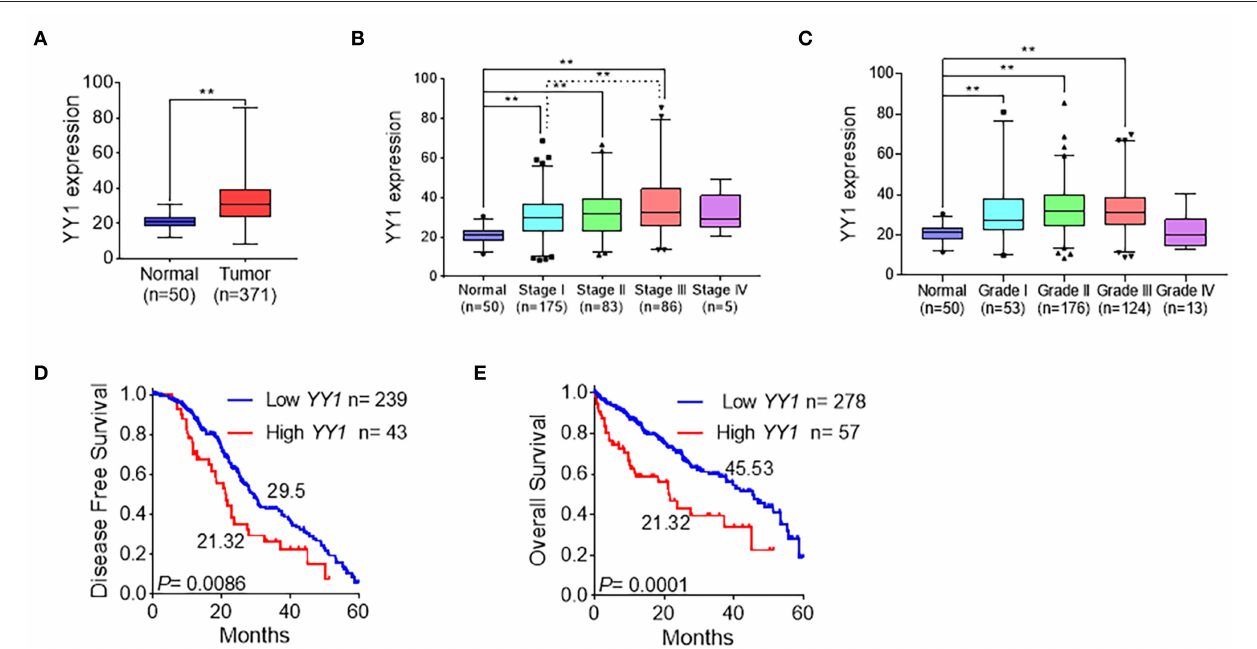
FIGURE 2 | YY1 indicated tumor malignancy in HCC. (A) Expression level of YY1 in primary tumors ( n = 371) and normal liver tissues ( n = 50) on the basis of the TCGA dataset. (B) Analysis of the expression levels of YY1 in TCGA LIHC samples on the basis of clinical stages. (C) Analysis of the expression levels of YY1 in TCGA LIHC samples on the basis of pathology grade. (D) Kaplan-Meier curve shows the 5-year disease-free survival rate of TCGA LIHC samples classified by YY1 expression. (E) High YY1 expression was significantly associated with poor overall survival in TCGA LIHC samples. ** P < 0.01.